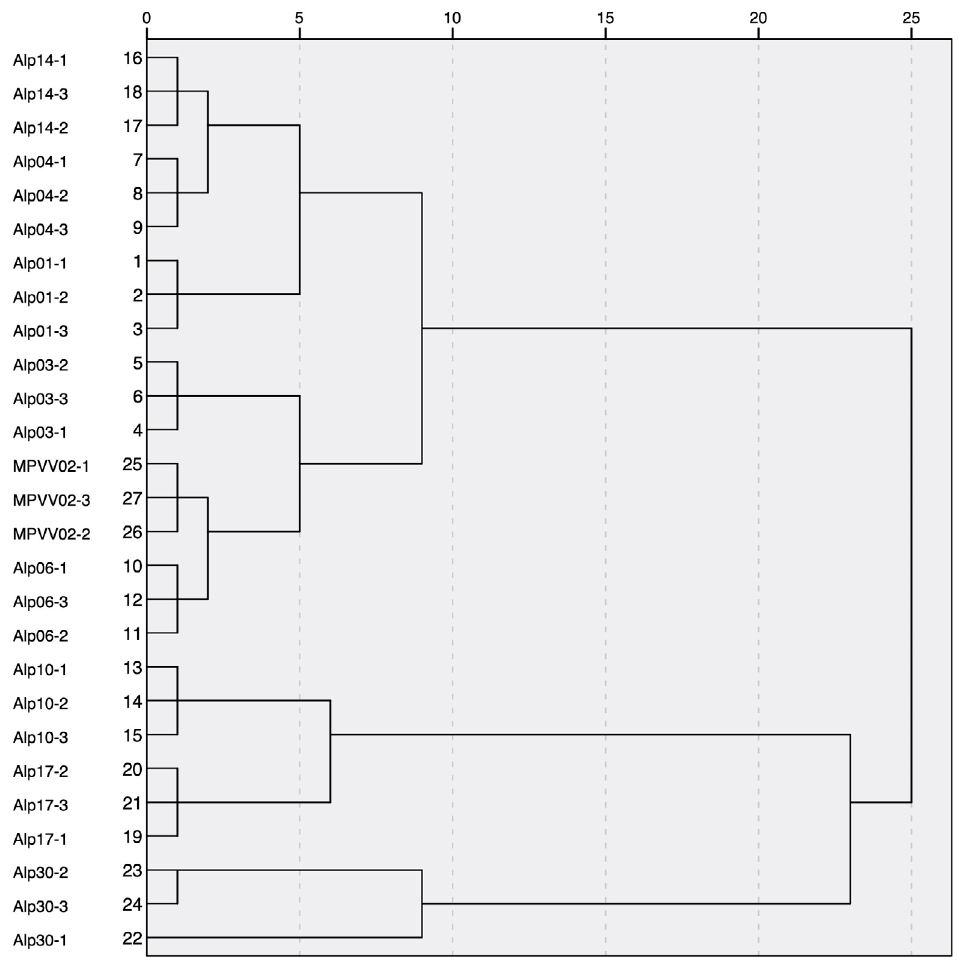
Figure 11. Dendrogram of samples. -1, -2, -3: independent sub-samples obtained for each sample. In all cases, sub-samples corresponding to the same sample are grouped together. This suggests a very similar and homogenous composition of the subsamples. Produced by O Lantes from SPSS Statistics software version 20